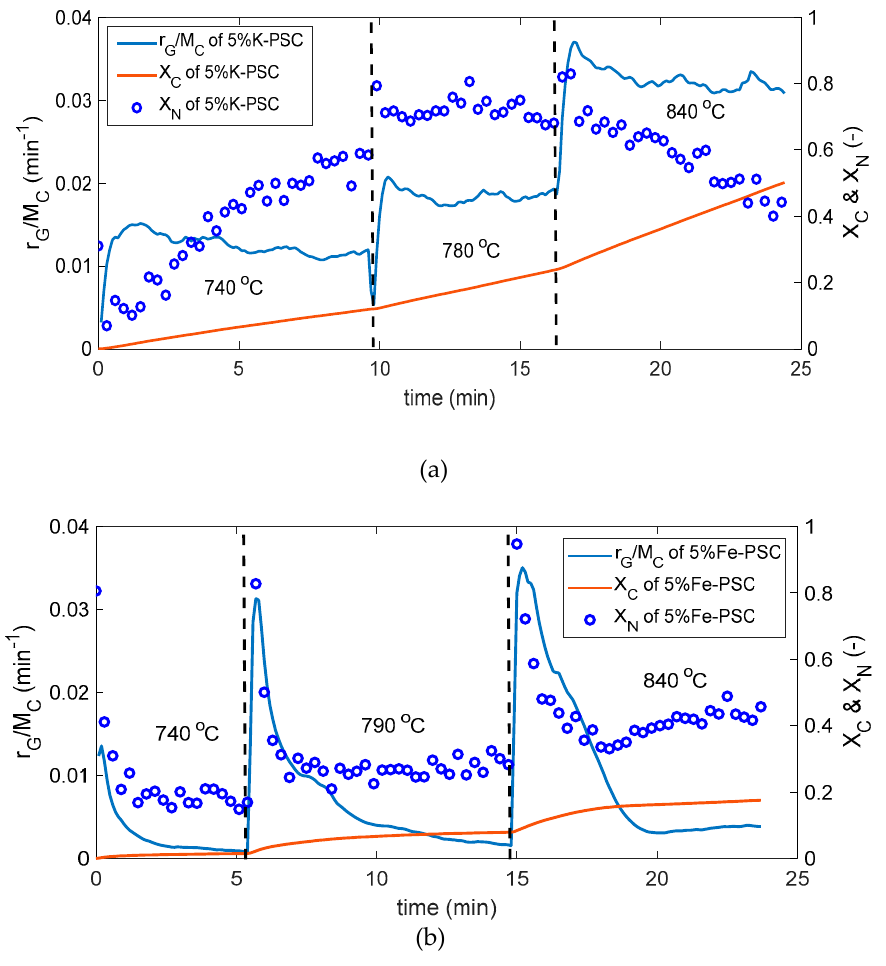
Figure 6. The tendency of calculated r G /M C and X N during tar reforming over; ( a ) 5%K-PSC; and ( b ) 5%Fe-PSC at a continuous three-stage tar reforming.